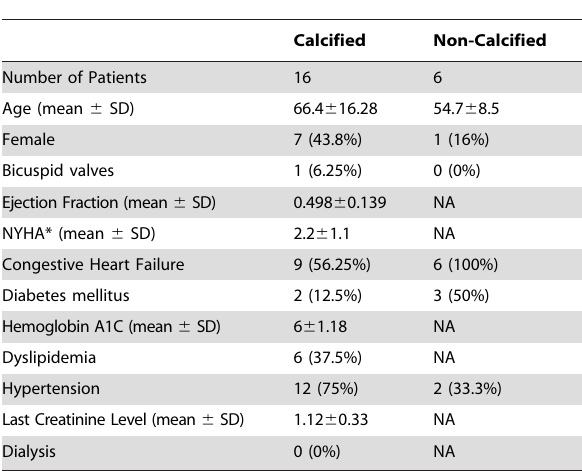
Table 1. Patient Characteristics.